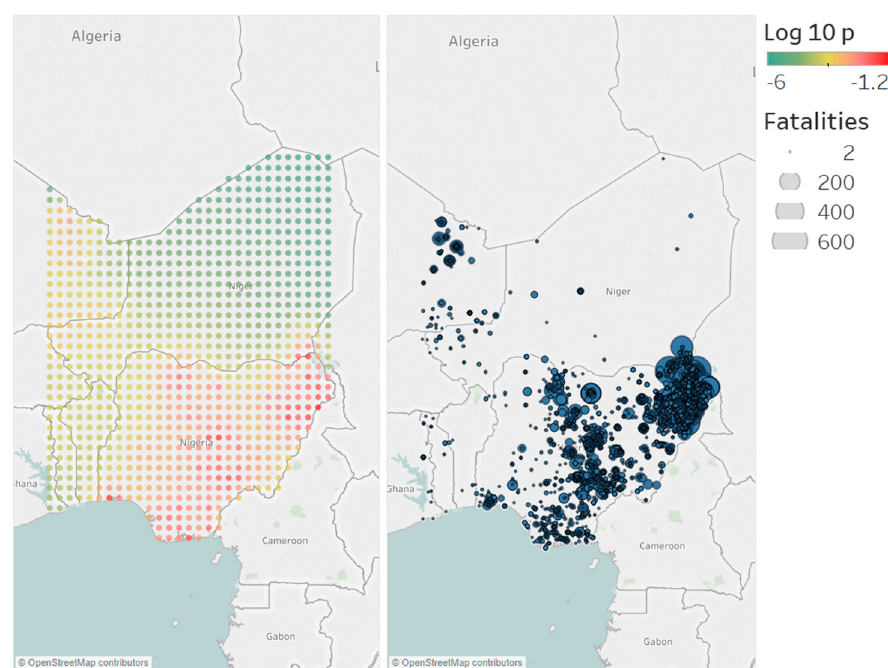
Figure 7. Spatial background distributions of the model with the largest log-likelihood for the region West Africa. The area is divided into 𝑁 (cid:3030) = 1102 cells. In these cells, the background intensity is assumed to be homogeneous. The cells give the probability of a background event occurring in that cell.